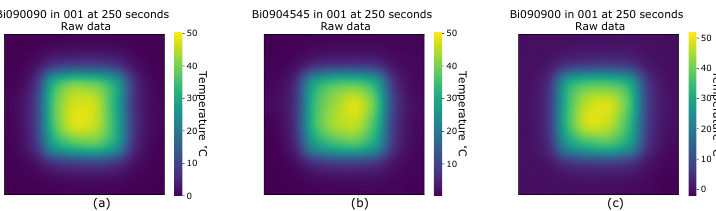
Figure 2. Heat maps of samples at 80 ◦ C and 250 seconds, ( a ) Biaxial 0/90/0/90, non symmetrical and balanced, ( b ) Biaxial 0/90/+45/ − 45, non symmetrical and unbalanced, ( c ) Biaxial 0/90/90/0, symmetrical and